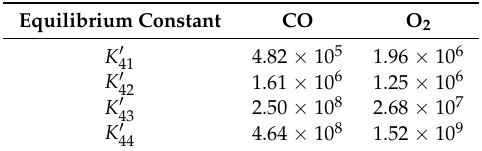
Table 1. Equilibrium constants for successive reactions of gases (carbon monoxide and oxygen) with hemoglobin.